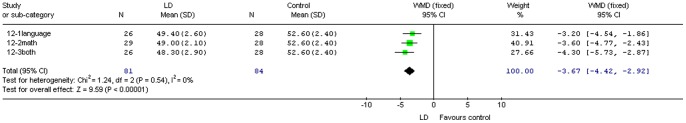
Differences between different types of learning difficulties.